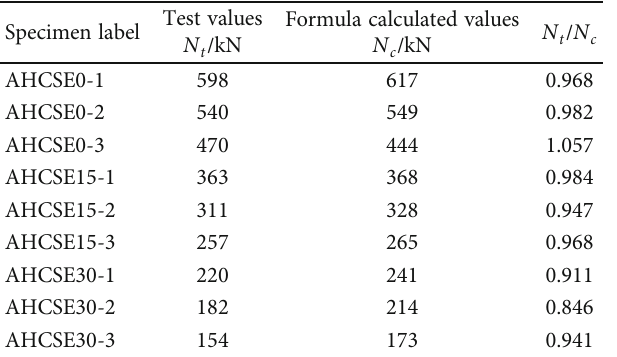
Table 9: Comparison of test values and theoretical formula calculation